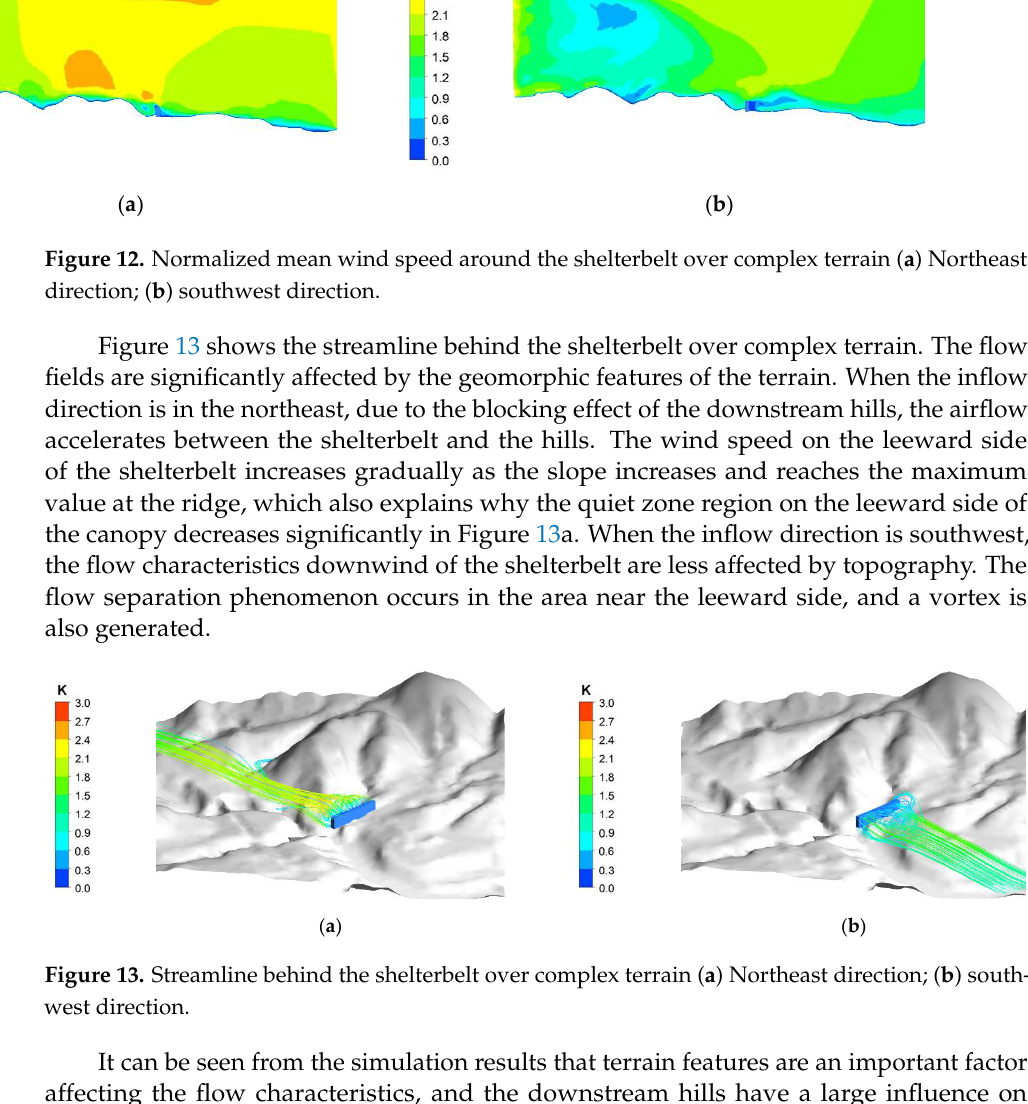
( b ) Figure 11. Comparison of the simulated and measured ( a ) wind speed ratio; ( b ) wind direction. The red dot indicates four different reference wind directions. Pinus is a common, tall tree planted in the study area. It is a pine evergreen coniferous tree with an average height in its forests up to 30 m. This height was used as the canopy height. Based on the previous discussion, the optimum vegetation canopy structure was confirmed to provide a guideline for designing a shelterbelt. In this simulation, the poros- ity of the canopy was 30%, and the width was 0.4 H. For natural barriers, as the approach angle (the angle of average wind direction from perpendicular to the windbreak) in- creases, the effective porosity of the windbreak becomes smaller. The shelter efficiency of a canopy is a function of approach angle and porosity. Medium-dense ( φ = 3 0%) canopy reaches a maximum shelter efficiency with the approach angle value of 90°. The distance between windbreaks and shelterbelt is about 3 H. At this distance, the wind speed is re- duced to the minimum value in the approach flow. Figure 12 presents the contours of normalized mean wind speed around the shelter- belt over complex terrain in a cross-section perpendicular to the canopy. It can be found